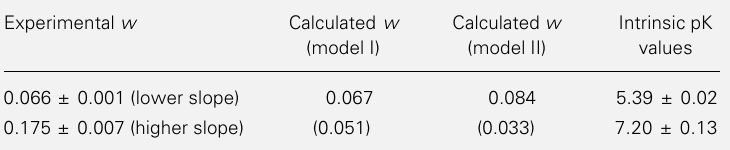
Figure 3 - Evaluation of w and intrinsic pK values. The protein net electric charge Z is related to the dissociation degree of the carboxyl group x i by the linear equation: pH - log[x i /(1-x i )] = (pK int ) i - 0.868 w Z. The intrinsic pK is given by the Y intercept. The nonlinear shape of experi- mental data (open circles) sug- gests more than one class of titratable carboxyl groups in the